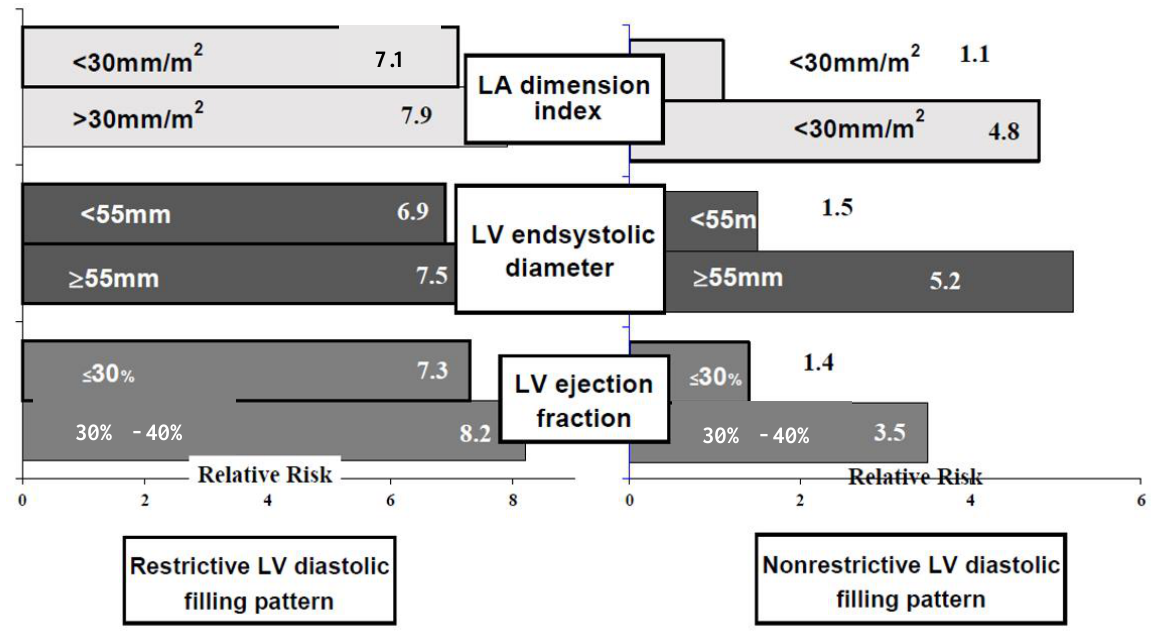
Figure 2. The early risk of death depending on the LVDFP in patients with AS and LV systolic dysfunction undergoing AVR.